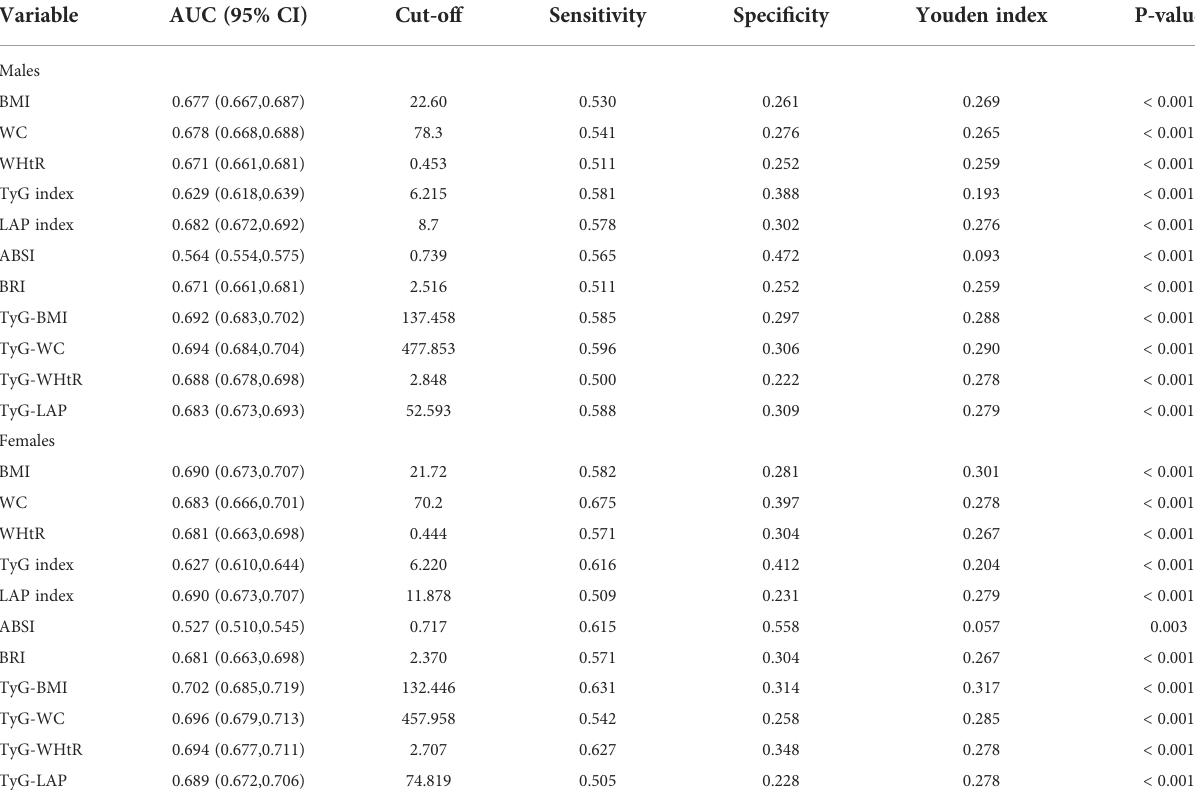
TABLE 4 Comparison of the ability of different indices to predict HUA.